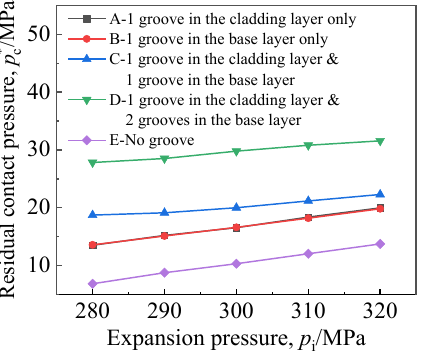
Figure 11. Effect of groove location on residual contact pressure.